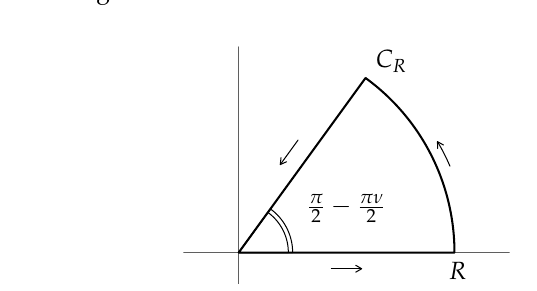
Figure 8. Path C R corresponding to the change of variables z (cid:48) = e i π 2 ( ν − 1 ) z in the second integral of